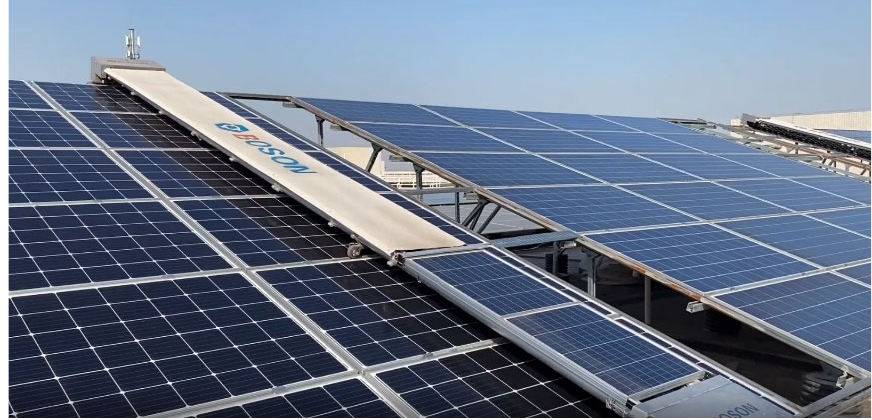
Figure 18. Solar cleaning robot [78].